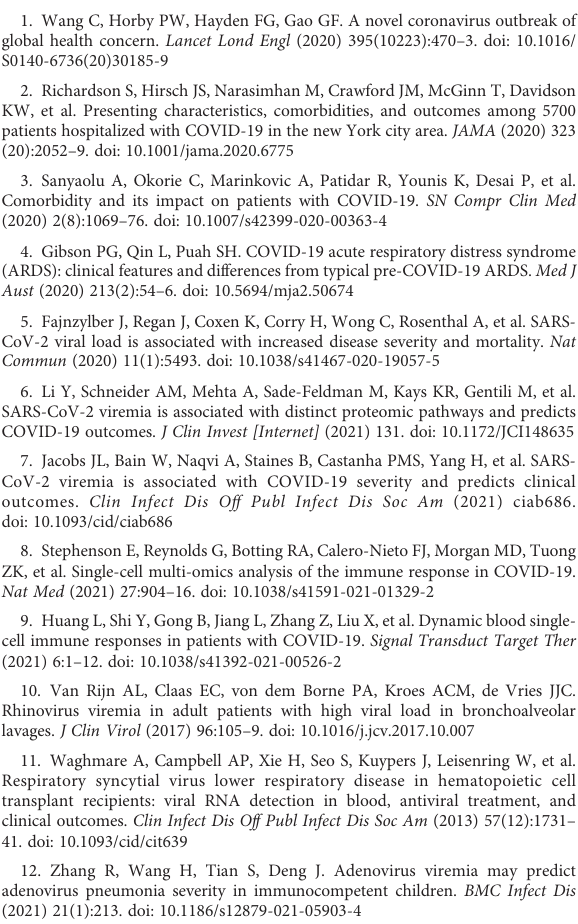
SUPPLEMENTARY FIGURE 1 (A) The fl ow cytometry gating strategy of seven population and purity. (B) theexpressionlevelofputativeSARS-CoV-2 entryreceptors,including ACE2, CD13, CD26, CD147, CD249, and TMRPSS2, were accessed by fl ow cytometry. The left panel shows the representative histogram plots of antibody staining gating on monocytes. A Fluorescence Minus One (FMO) control showed in blueand the sample in red. The right panel summarizes each receptor expression level in different cell types (n=20). SUPPLEMENTARY FIGURE 2 Transcriptional signatures of immune cell subpopulations during naturally acquired COVID-19 diseases. (A) Linear discriminant analysis of immune responses for various groups with all seven immune cell types. (B) Linear discriminant analysis of immune responses for each cell type for different study groups. (C-I) Heatmaps demonstrating transcriptional patterns